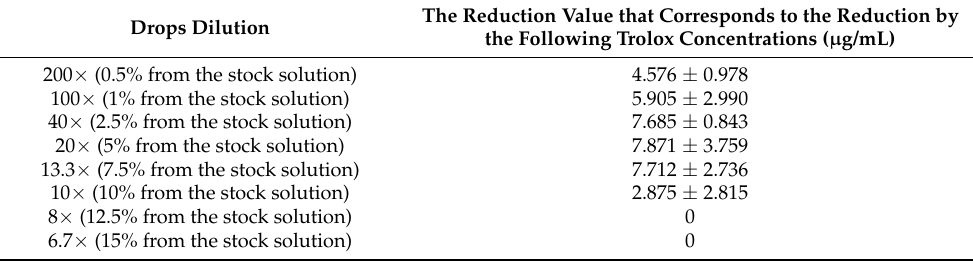
Table 1. DPPH method—free radicals scavenging activity performed by different dilutions of the tested